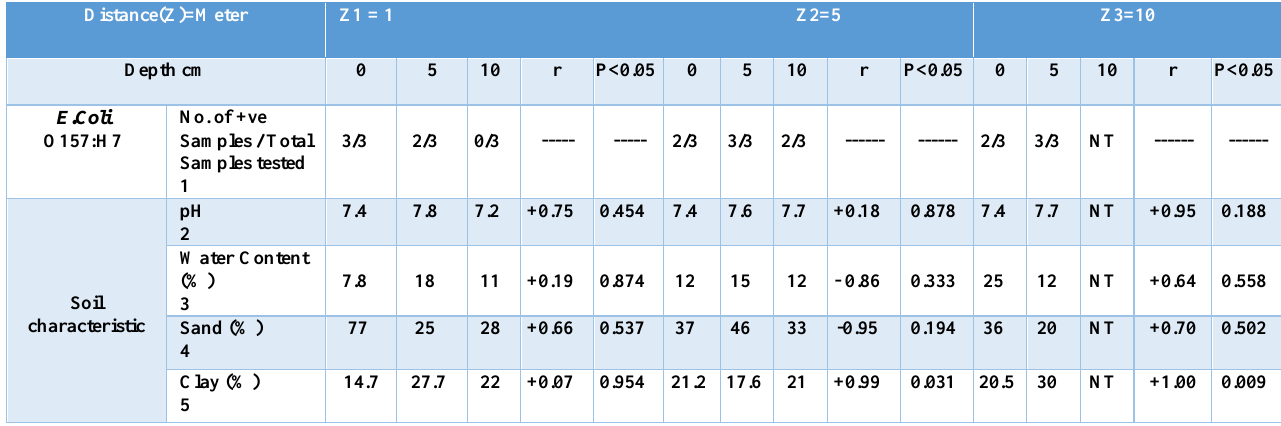
Table, 7: Correlation (r) between the prevalence of E.Coli O157:H7 and physico-chemical characteristics of the soil at the rear (Re) side of the dairy